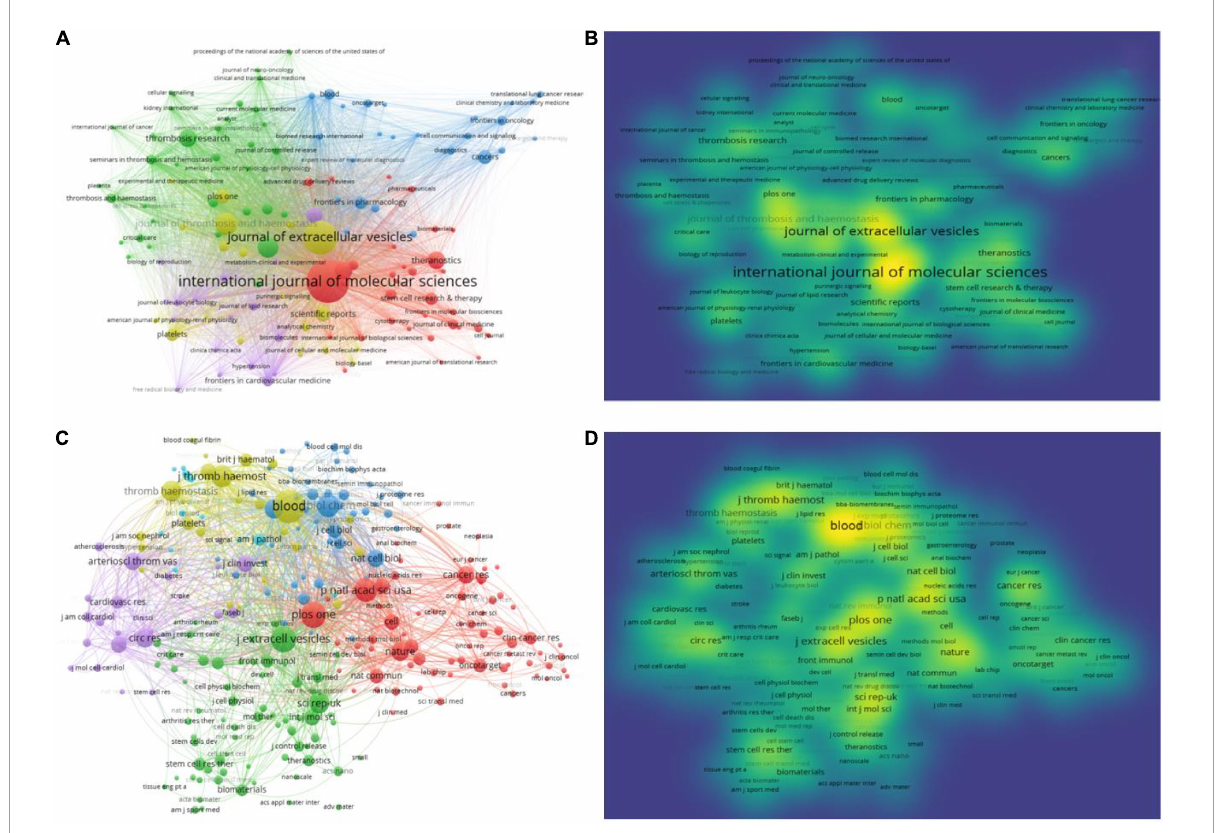
FIGURE4 Journals that published articles on platelet exosomes. (A) VOSviewer-based journal collaboration. (B) VOSviewer-based density map of journals’ distribution. (C) VOSviewer-based collaboration among co-cited journals. (D) VOSviewer-based density map of article distribution among co-cited